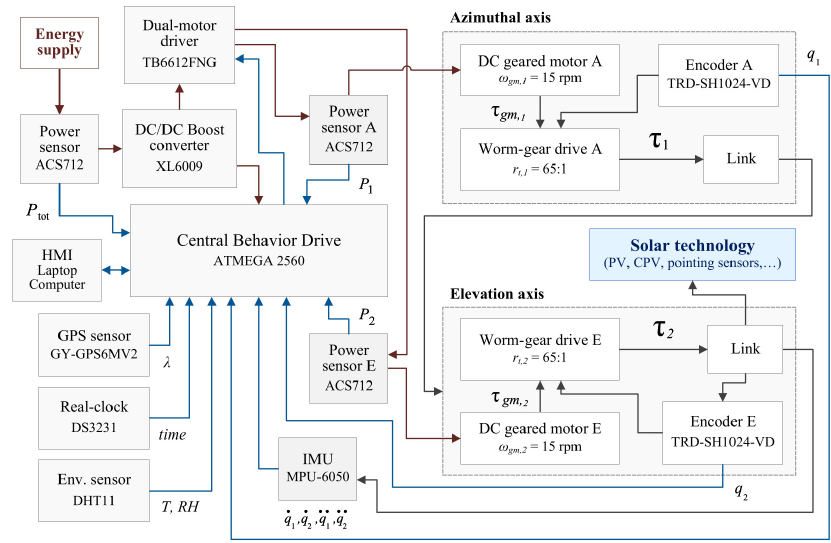
Figure 9. Final architecture obtained of the dual-axis STS; red lines represent power connections, blue lines for data buses, and gray lines for physical connections.